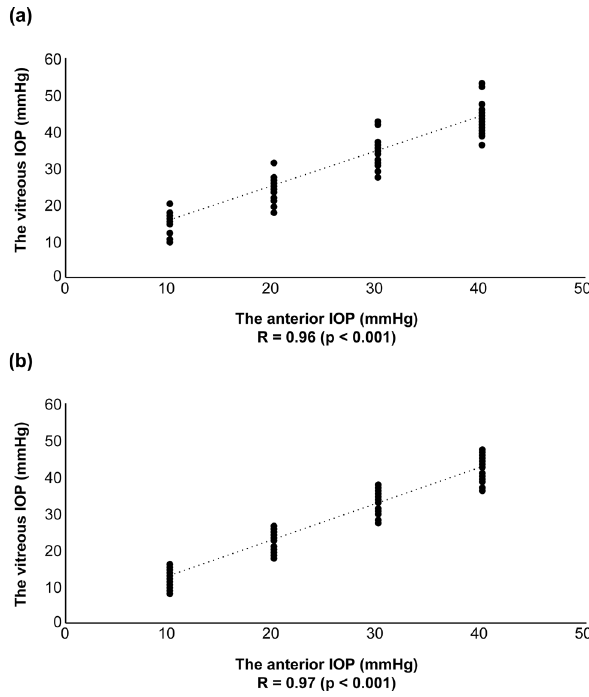
Figure 2. Scatterplots of the vitreous cavity IOP under different anterior chamber IOP (abscissa) in the phakia group (n = 12) ( a ) and aphakia group (n = 12) ( b ). The vitreous IOP was well-correlated with the anterior IOP in both